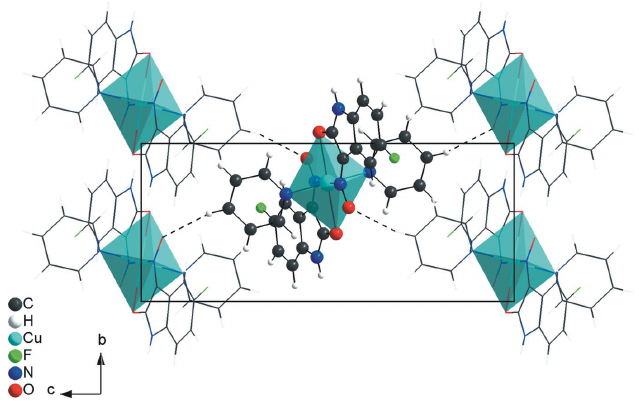
Figure 4 Partial crystal packing of the title compound, viewed down the a axis, showing the C—H (cid:2)(cid:2)(cid:2) O interactions (dashed lines) organized in a C (8) graph-set motif along the [001] direction. bonded network (Table 1). The complexes are linked by centrosymmetric pairs of C—H (cid:2) (cid:2) (cid:2) F interactions into dimers with graph-set motif R 22 (22). The dimers are the subunits of the periodic arrangement along the [110] direction (Fig. 3).